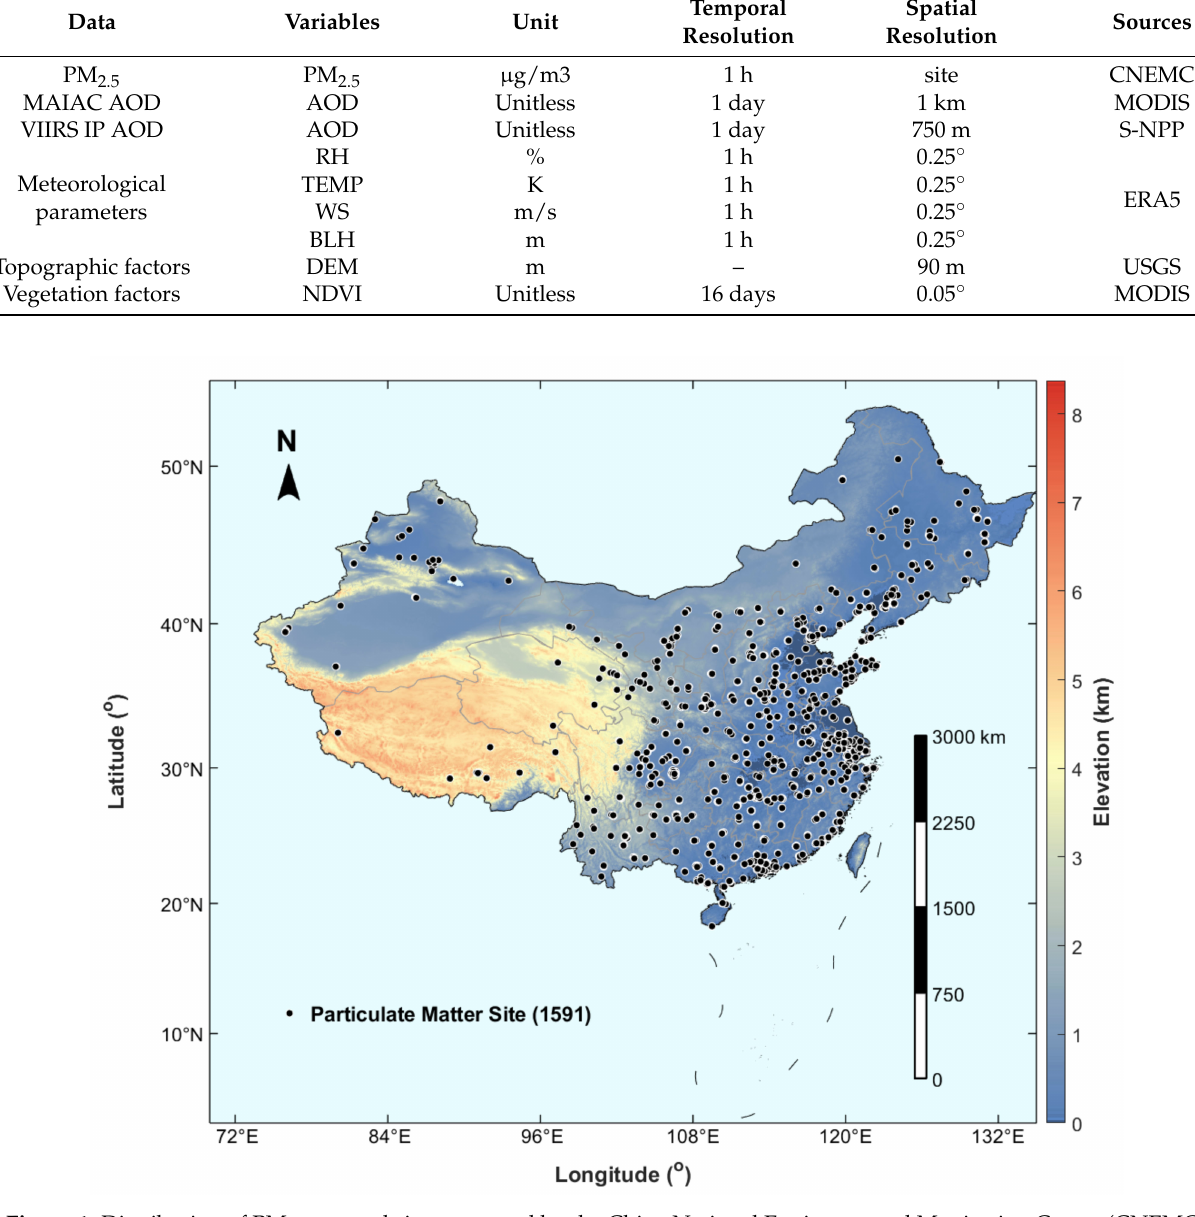
Figure 1. Distribution of PM measured sites managed by the China National Environmental Monitoring Center (CNEMC). The total number of monitoring sites is